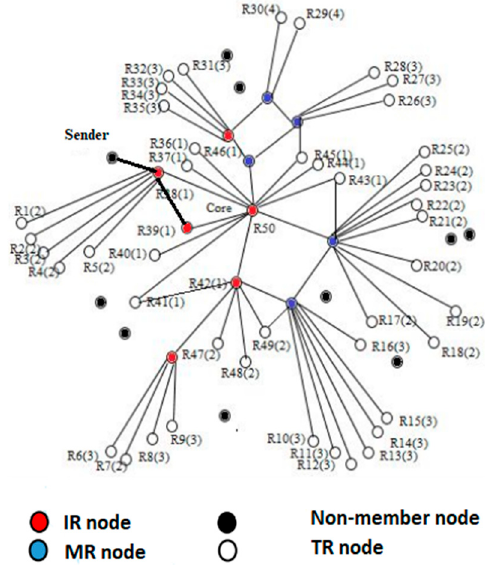
Figure 4. Data Forwarding in EERASCA.